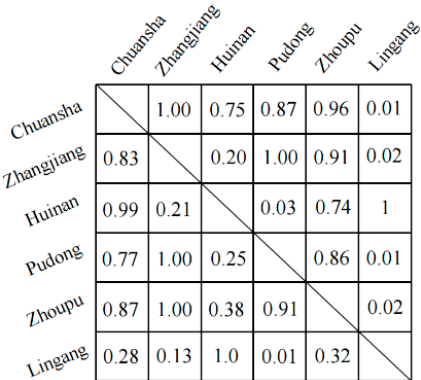
Figure 9. The weight matrix of six counties.